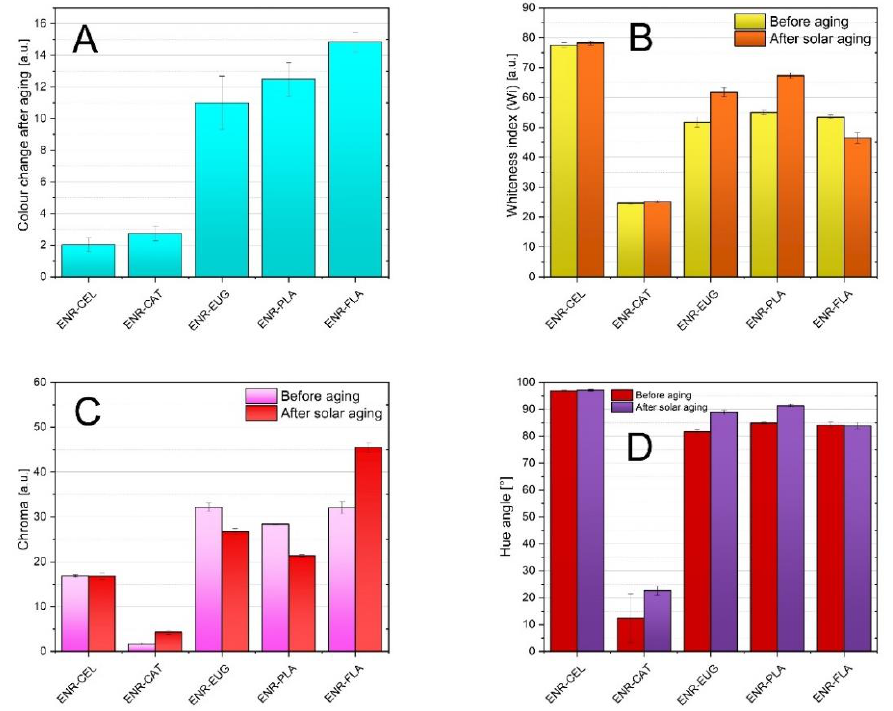
Figure 2. The color change ( A ), whiteness index ( B ), chroma values ( C ) and hue angles ( D ) of ENR- based composites.